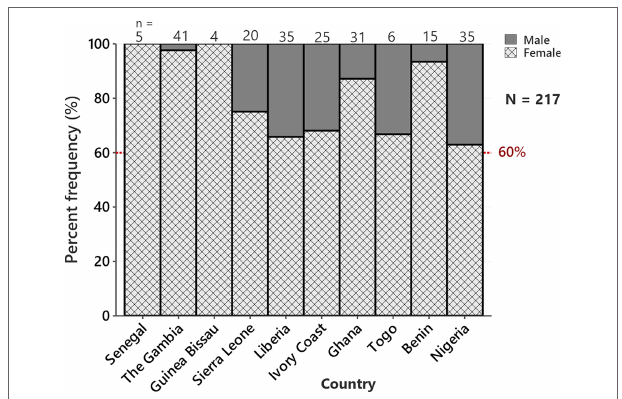
FIGURE 2 | Gender disaggregation of shellfishery resource users’ overall participation for each country. Number of respondents, n = 217; Senegal, Guinea-Bissau and Togo had focus group discussions of at least five resource users per meeting—the response from each meeting counted as one ( n = 1) for these countries. [Data source: Resource user survey from this